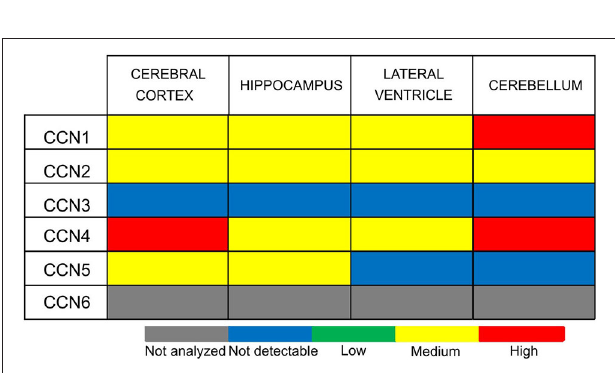
et al., 2012). However, CCN3 immunoreactivity was also observed in astrocytes in the rat cerebral cortex, corpus callosum, and hippocampus (Le Dréau et al., 2010a). CCN3 mRNA and CCN3 protein are also expressed in specific structures in the developing chicken eye, including the lens, ciliary body, optic nerve, pecten, and retina (Laurent et al.,